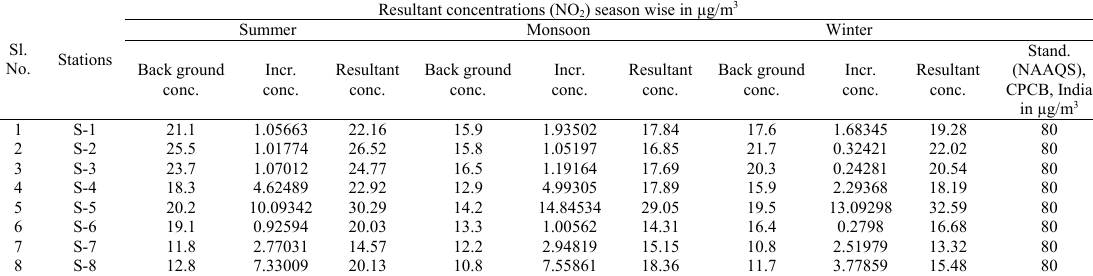
Table 5: Resultant concentrations respective to station and season wise for NO 2